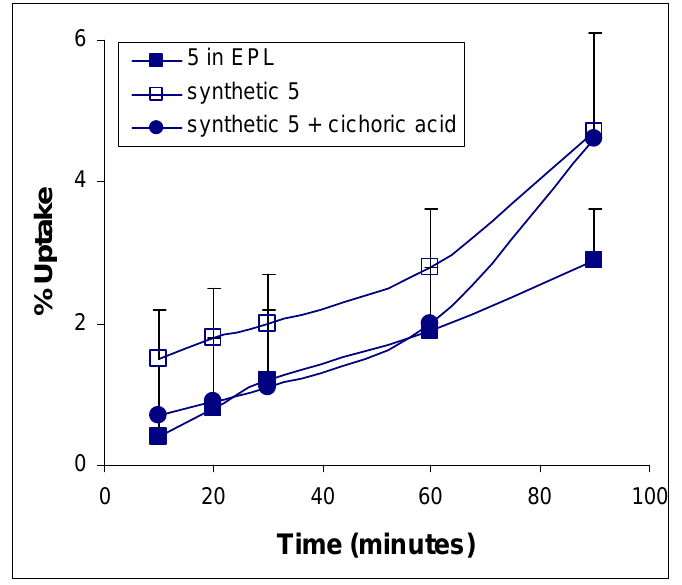
Figure 6: Effect of other compounds on the potential bioavailability compound 5 using Caco-2 monolayers.